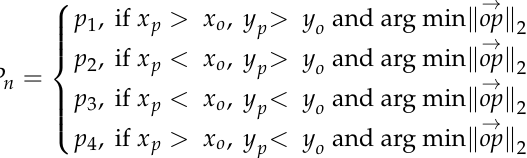
→ op is the vector between points o and p . and